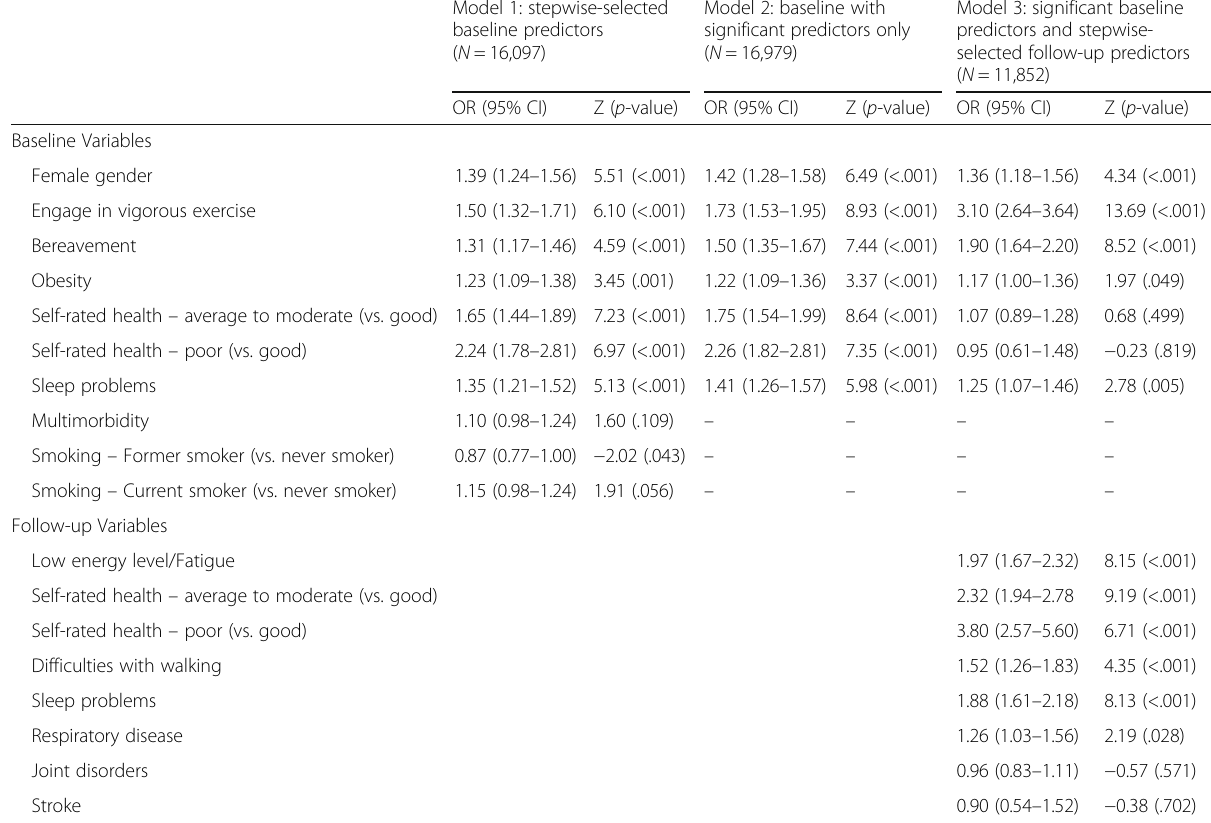
Table 2 Hierarchical pain predictive models: stepwise-selected baseline predictors, significant baseline predictors only ( p < 0.05), significant baseline predictors and stepwise-selected follow-up predictors